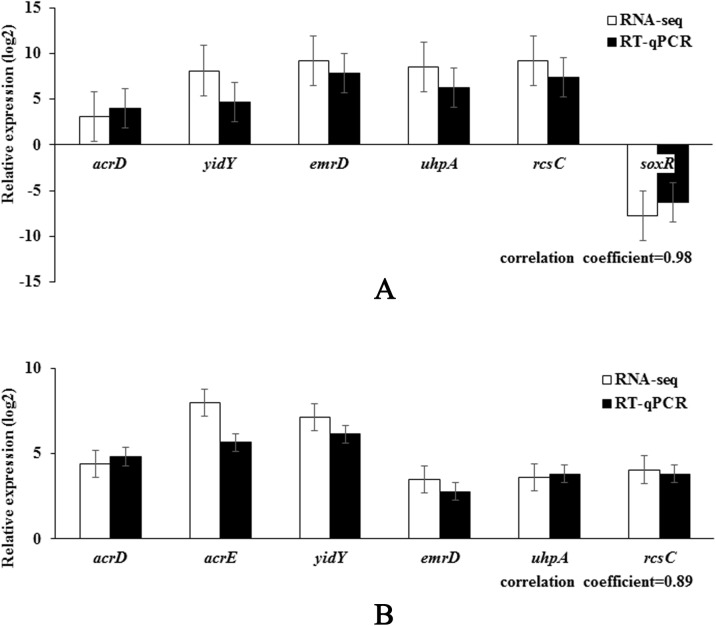
Validation of the RNA-seq assay of selected genes with a RT-qPCR analysis.RT-qPCR data confirmed the expression trends observed in the RNA-Seq data for a number of genes in resistant strains TN4 (A) and TW4 (B) compared with parental strain T0.